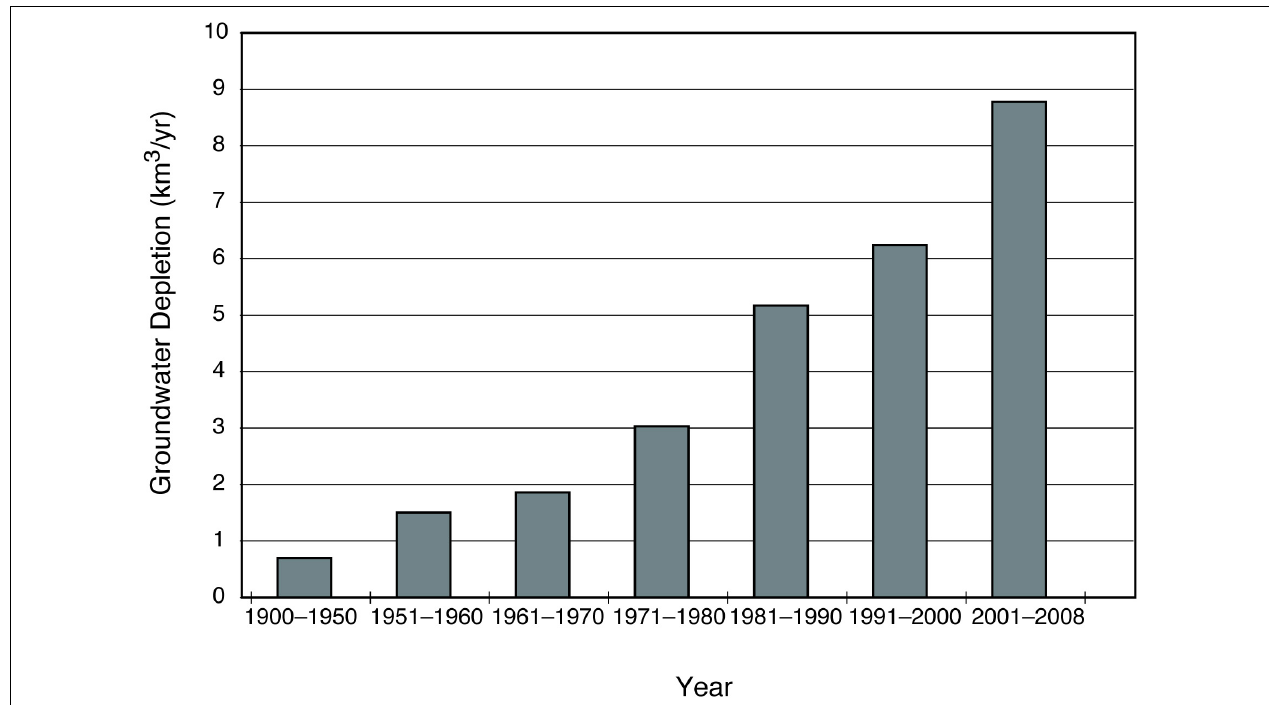
FIGURE 1 | The depletion of groundwater in the United States Gulf and Atlantic Coastal plain aquifers. Before 1950 depletion rates were less than 1 km 3 /year. Early in the 21st century this increased to almost 9 km 3 /yr. Data from Konikow